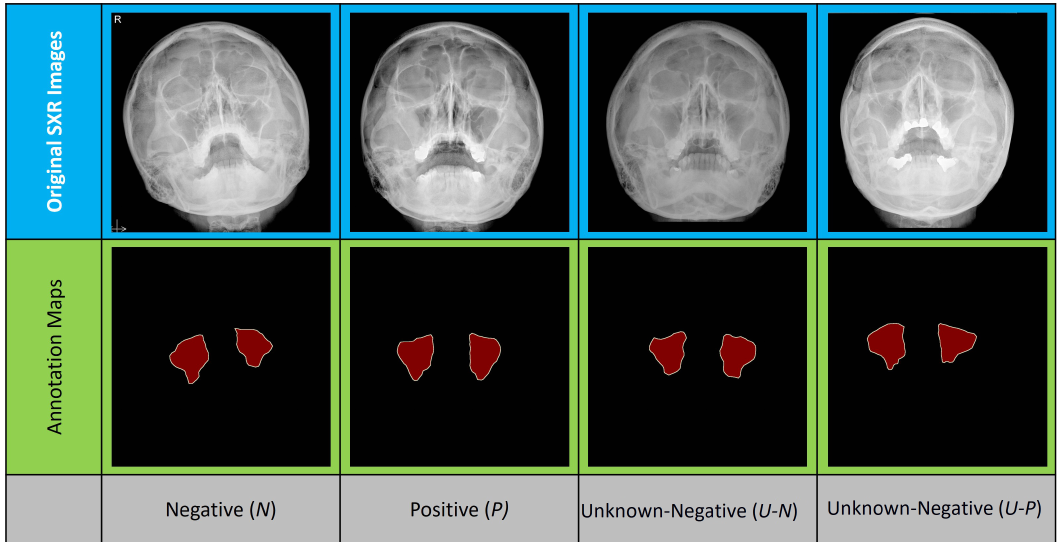
Figure 2. Illustration of occipitomental-view skull radiography (SXR) dataset. The negative (N) and the positive (P) folds are containing plain SXR images. The unknown-negative (U-N) and the unknown-positive (U-P) folds are containing plain SXR images with dubious